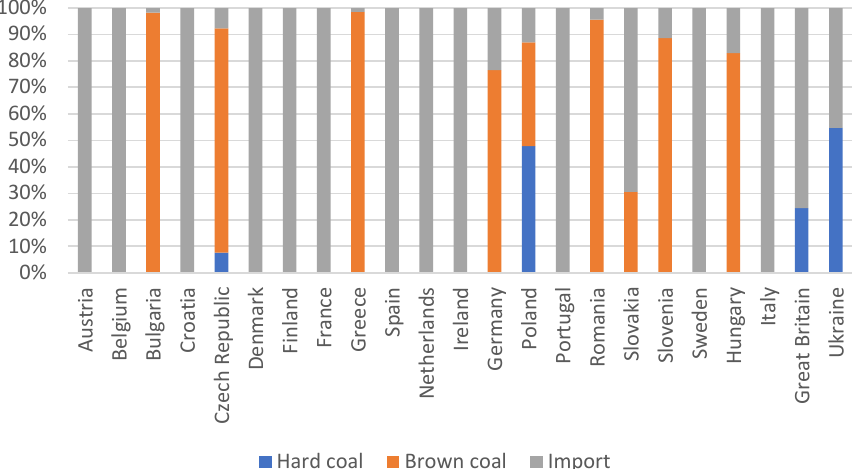
largest producer of hard coal in Europe over the course of almost three decades.